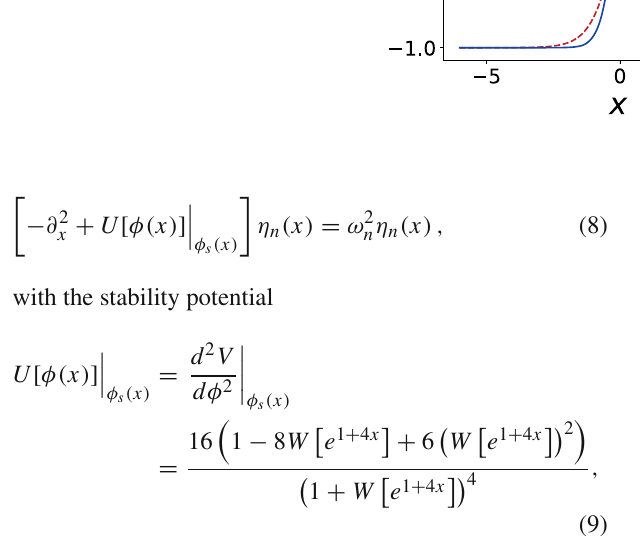
Fig. 1 a Soliton profile. b Energy density. The solid line (blue) and the dashed line (red) show the soliton in our model and the kink of φ 4 theory, respectively